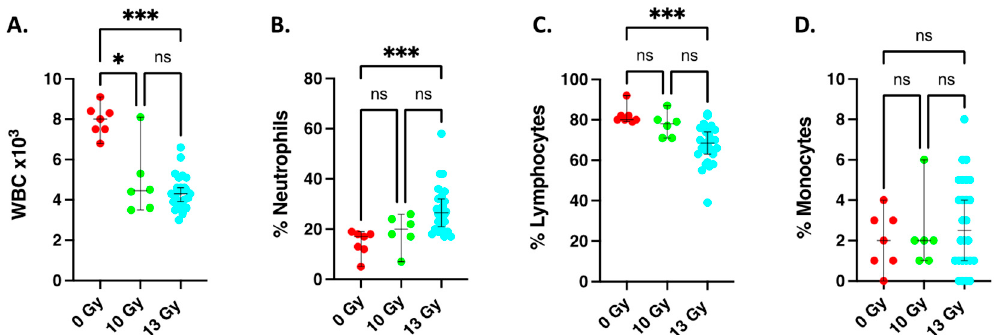
Figure 3. Graphical representation of circulating white blood cell counts 2 weeks after whole thorax lung irradiation (WTLI). Blood was harvested from female nonirradiated, and age-matched rats given 10- and 13-Gy WTLI and the white cell count determined as described (see Section 4). ( A ) Total white blood cells/microliter. ( B ) Percent neutrophils. ( C ) Percent lymphocytes. ( D ) Percent monocytes. The data are presented as medians and 95% confidence intervals: * = p < 0.0332, *** = p < 0.0002, ns = no statistical